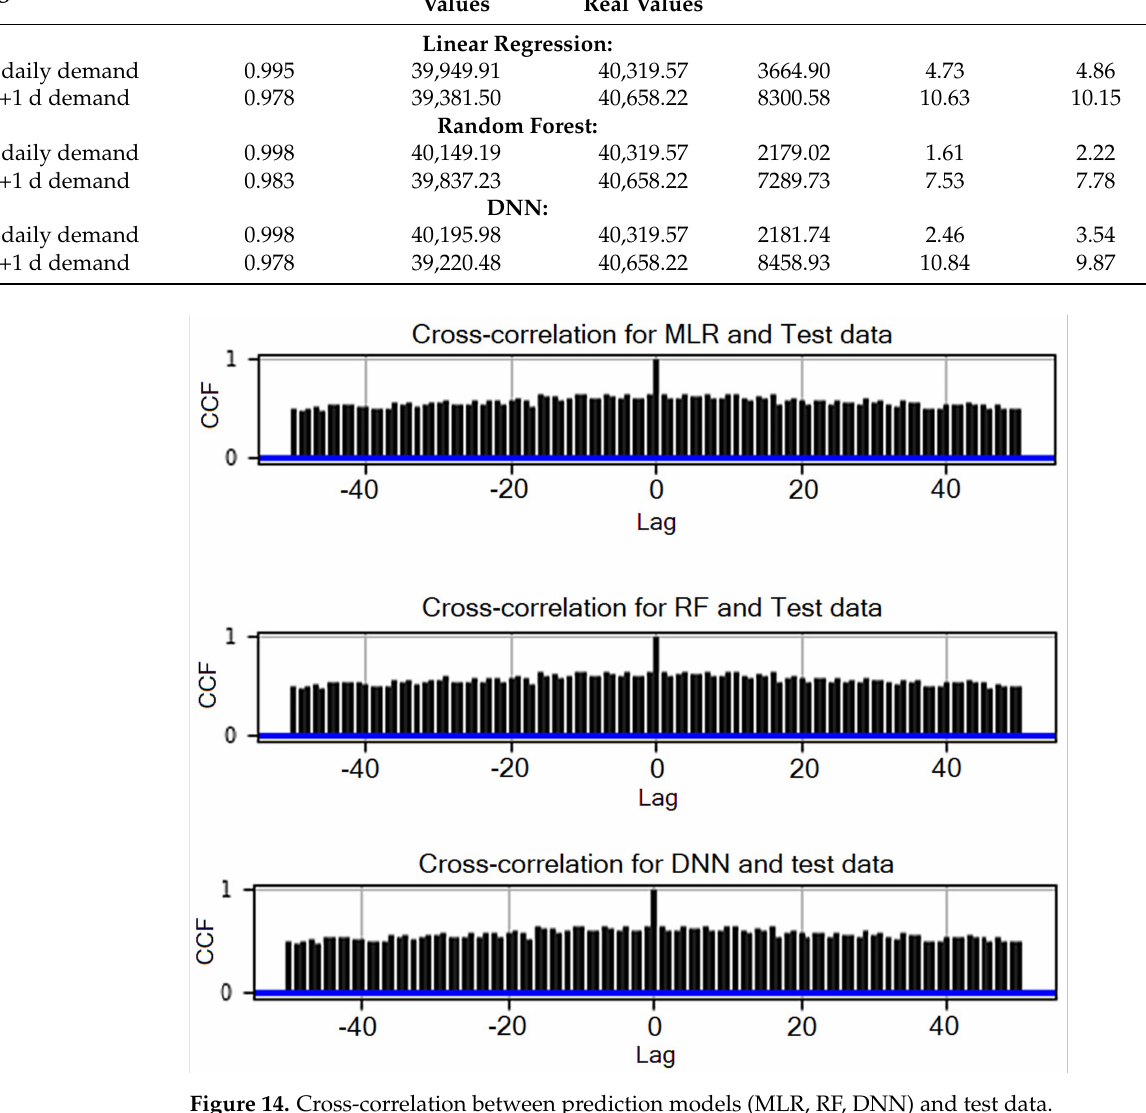
Figure 14. Cross-correlation between prediction models (MLR, RF, DNN) and test